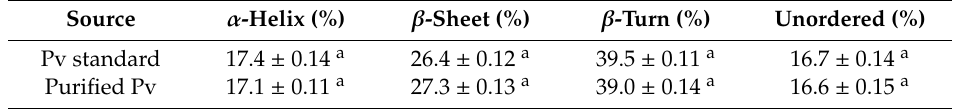
Table 7. Content of the secondary structure for Pv standard and purified Pv.